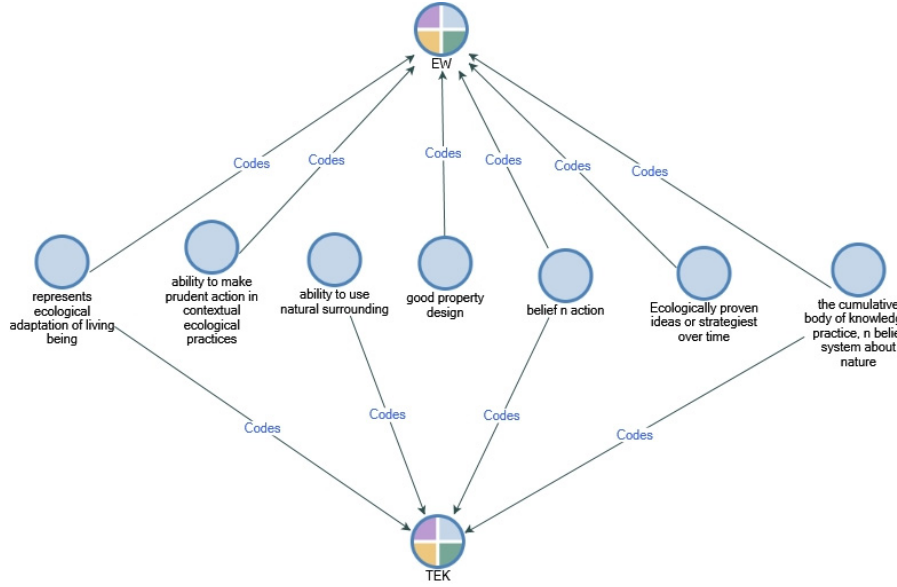
Figure 5. The comparison diagram of definitions between TEK and EW.